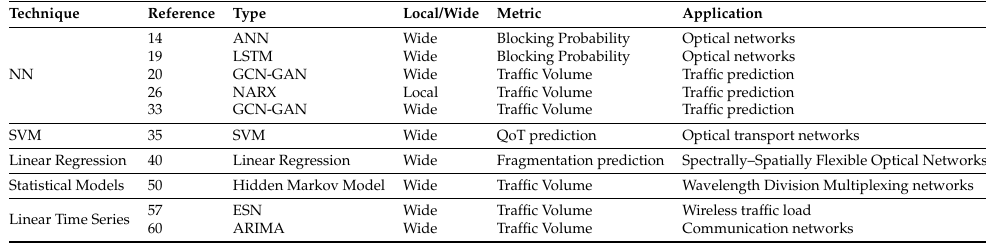
Table 2. List of papers on long-term communication traffic prediction.